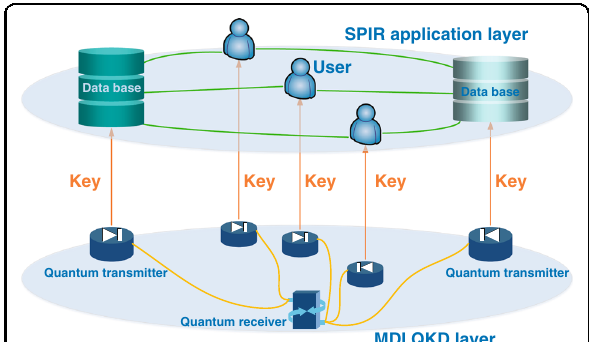
Fig. 1 Schematic view of QKD-based SPIR. The symmetric private information retrieval (SPIR) application is supported by a measurement-device-independent quantum key distribution (MDI QKD)